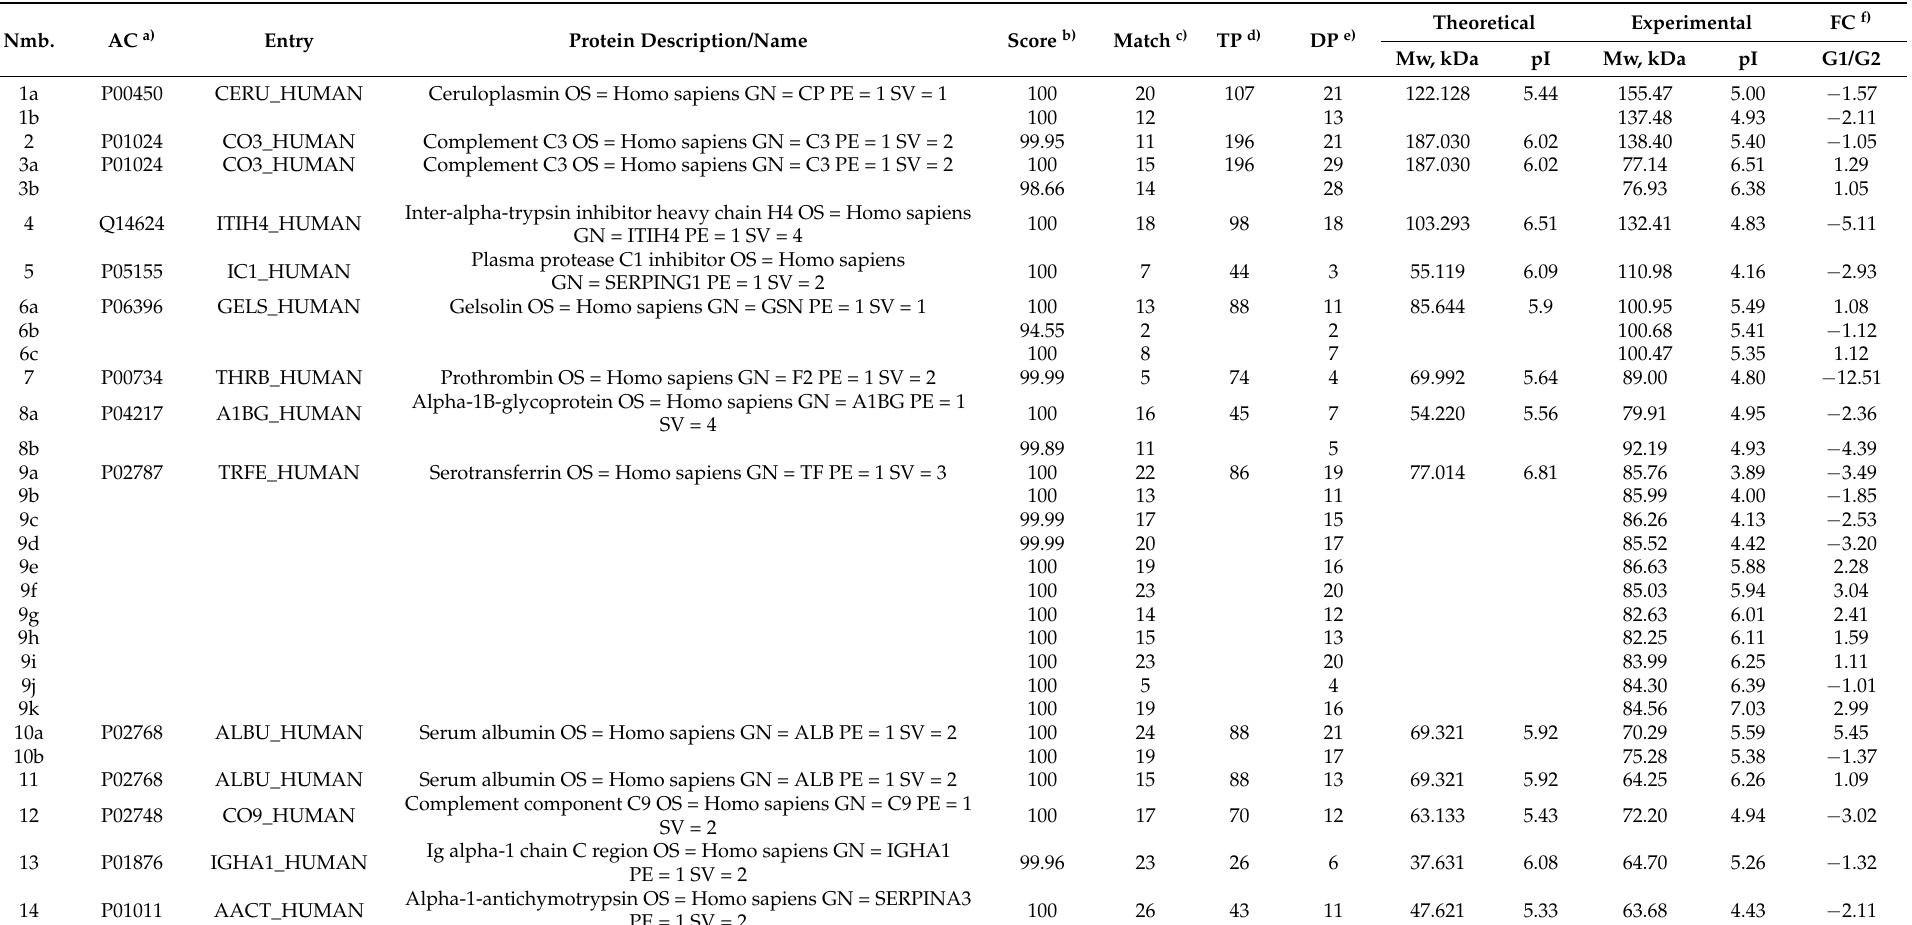
Table 1. The summarized search results (by UniProt, Expasy) of proteins identified from 2DE gels representing protein maps of amniotic fluid of normal and polyhydramnios pregnancies fractionated in the pI 3–11 range. An increase in spot intensity yields a positive fold-change and a decrease accordingly a negative fold- change in AFN/AFP (marked as G1/G2). a ) AC—accession number; b ) Score—protein Score C.I. %; c ) Match—Matching (sequence coverage, %); d ) TP—Theoretical Peptides; e ) DP—Digest Peptides; f ) FC—Fold